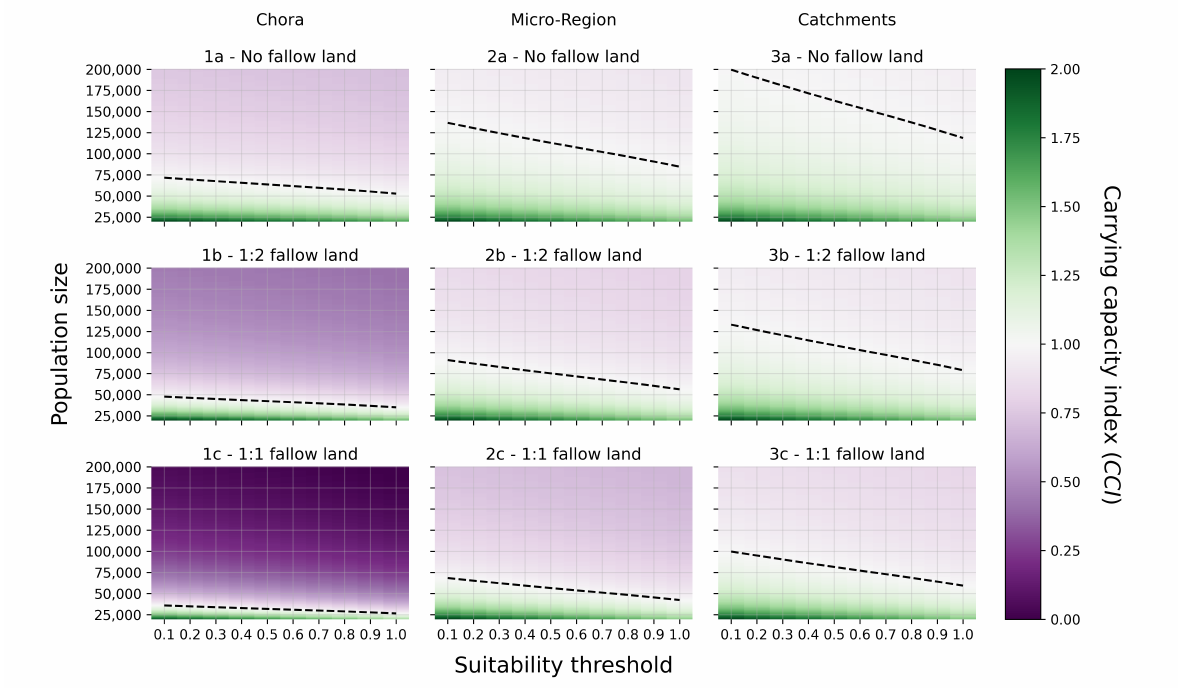
Figure 4. Carrying capacity estimation of the normal labour scenario for the different heuristics of the Pergamon’s complementary area ( 1 chora; 2 Micro-Region; 3 catchment-based delineation), under three different fallow land scenarios ( a no fallow; b 1:2 fallow; c 1:1 fallow land) and 2100 kcal daily calorie requirements. Green colours ( CCI > 1.0) indicate that carrying capacity is not reached, and enough land for cultivation is available. The opposite is true for purple colours ( CCI < 1.0); white ( CCI ≈ 1.0) indicates that the carrying capacity is met or almost met. The black line shows where the CCI is exactly